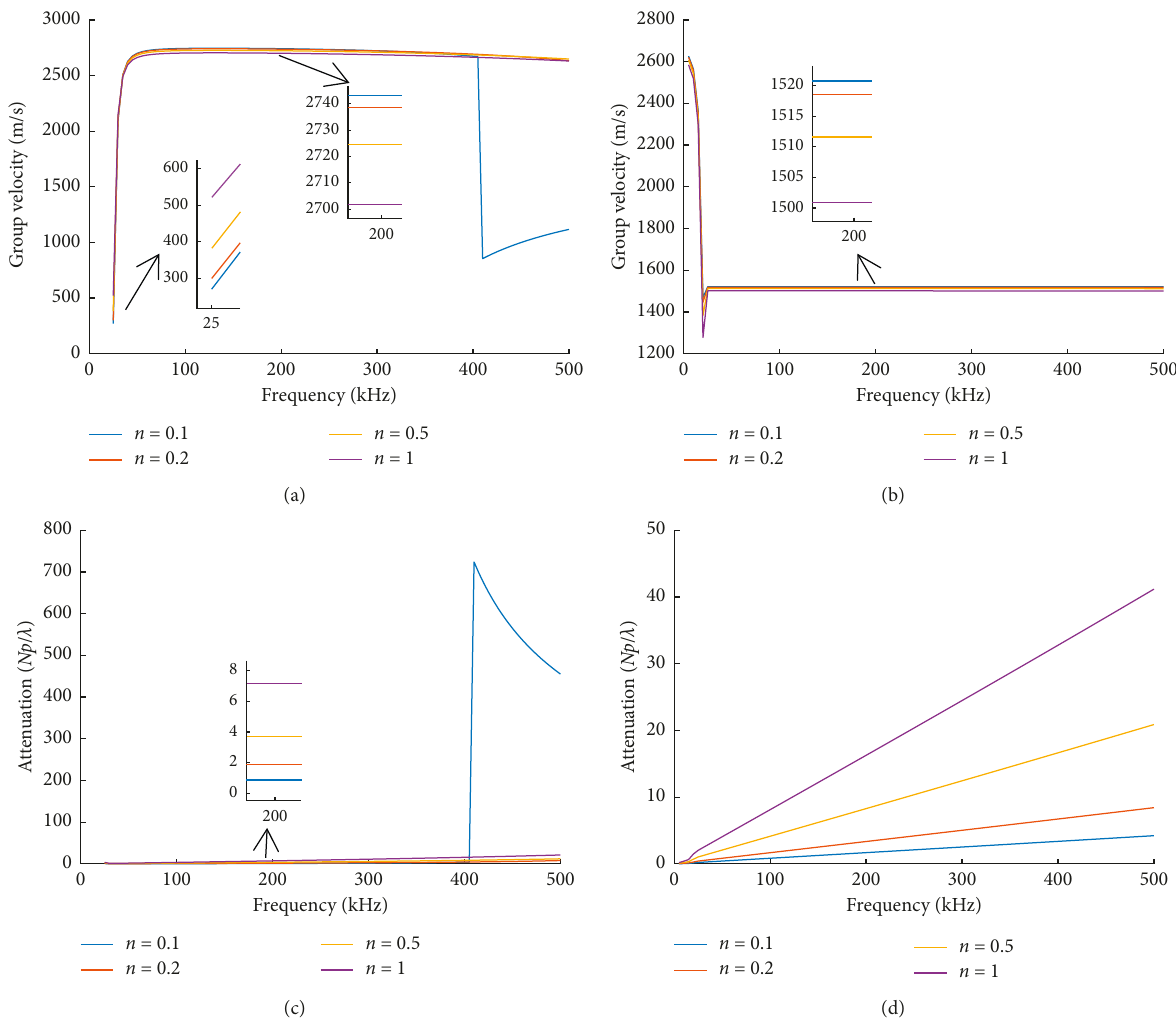
Figure 8: Group velocity and attenuation dispersion curves of the guided wave, n � 0.1, 0.2, 0.5, and 1. (a) Group velocity curves of L ( 0 , 2 ) . (b) Group velocity curves of T ( 0 , 1 ) . (c) Attenuation curves of L ( 0 , 2 ) . (d) Attenuation curves of T ( 0 , 1 )